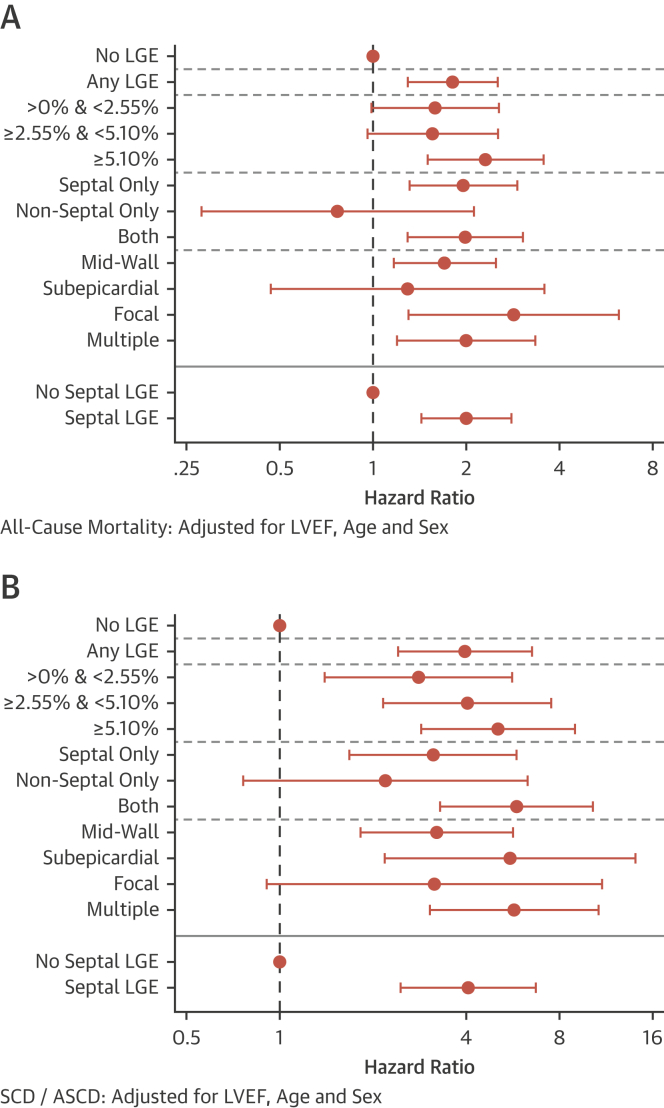
Outcome Related to Extent, Location, and Pattern of Late Gadolinium EnhancementForrest plots showing the estimated adjusted hazard ratios (HRs) for (A) all-cause mortality and (B) the sudden cardiac death (SCD) endpoint, per patient group based on late gadolinium enhancement (LGE) extent, location, and pattern. For each model the different LGE HRs are compared to the No-LGE group, except for the final model where “septal LGE” is compared to “no-Septal LGE.” Abbreviations as in Figure 3.